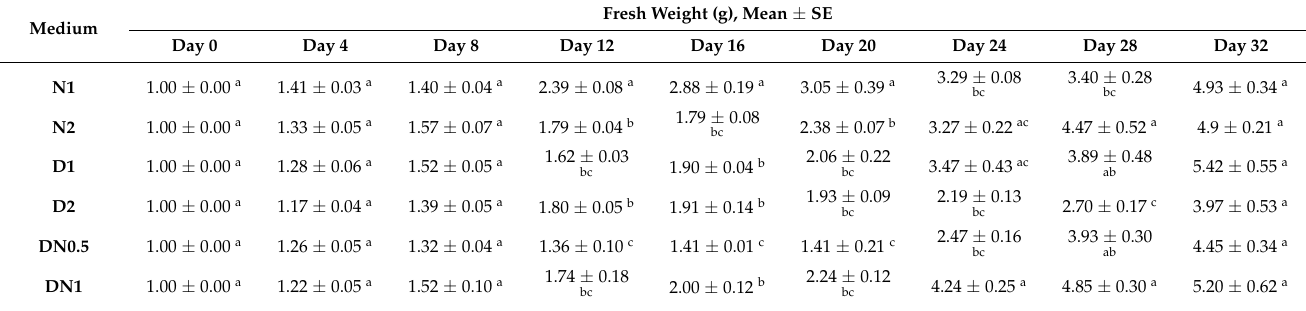
Table 2. Fresh weights of callus multiplied on MS medium fortified with different concentrations of NAA and 2,4-D.